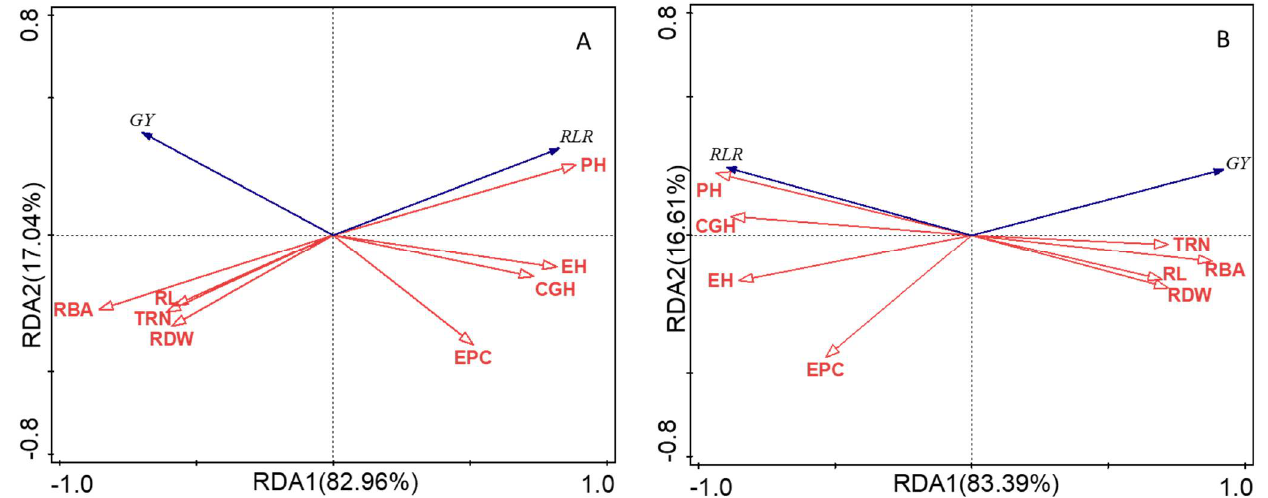
Figure 5. The redundancy analysis (RDA) used to identify the relationships among the grain yield, root lodging rate, and the maize shoot-root traits. ( A ) The relationships between grain yield, root lodging rate (blue arrows), and the maize shoot-root traits (red arrows) in 2019; ( B ) the relationships between grain yield, root lodging rate (blue arrows), and the maize shoot-root traits (red arrows) in 2020 (GY: grain yield; RLR: root lodging rate; PH: plant height; EH: ear height; CGH: center of gravity height; EPC: ear height coefficient; TRN: total root number; RL: root length; RBA: root breadth area; RDW: root dry weigh).